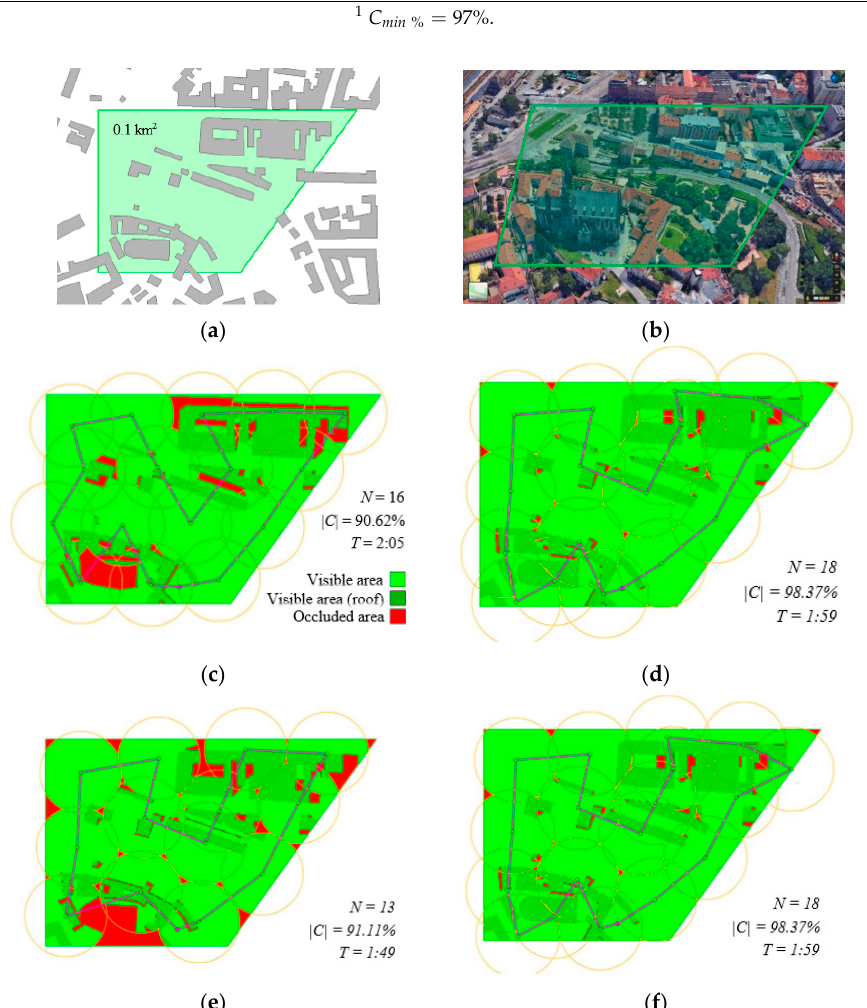
Figure 5. Scenario sc01: ( a ) area of interest and objects; ( b ) real environment; ( c ) original CAR model; ( d ) optimized waypoints; ( e ) solution by the improved CAR model for C min % = 90%; ( f ) solution by the improved CAR model for C min % =